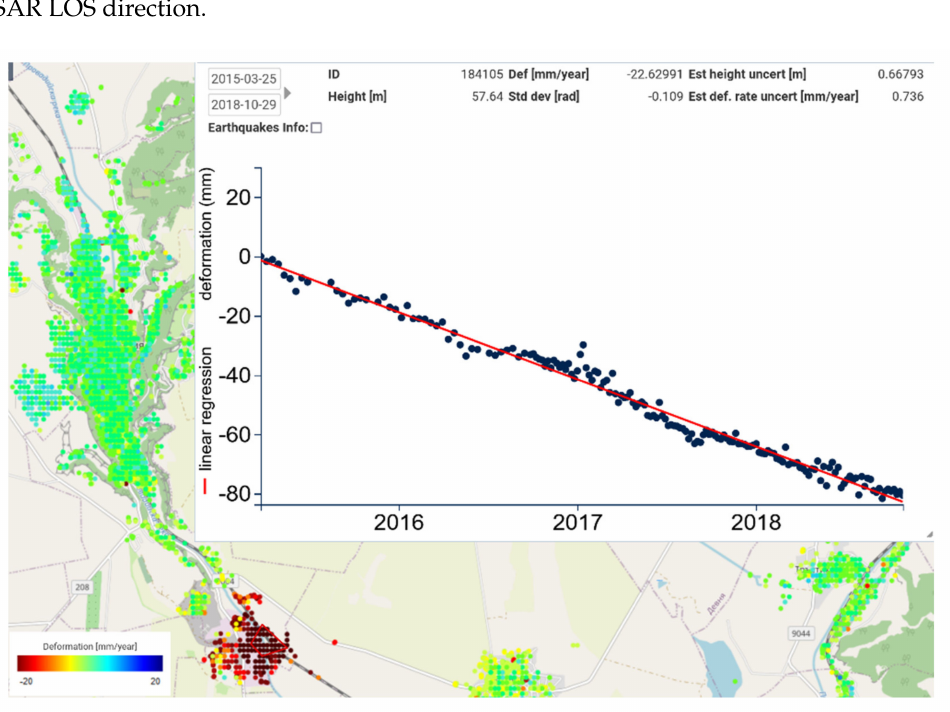
Figure 9. Ground subsidence related to salt exploitation in Provadia area, northeastern Bulgaria. Temporal series represents an average of profiles for targets located in the red